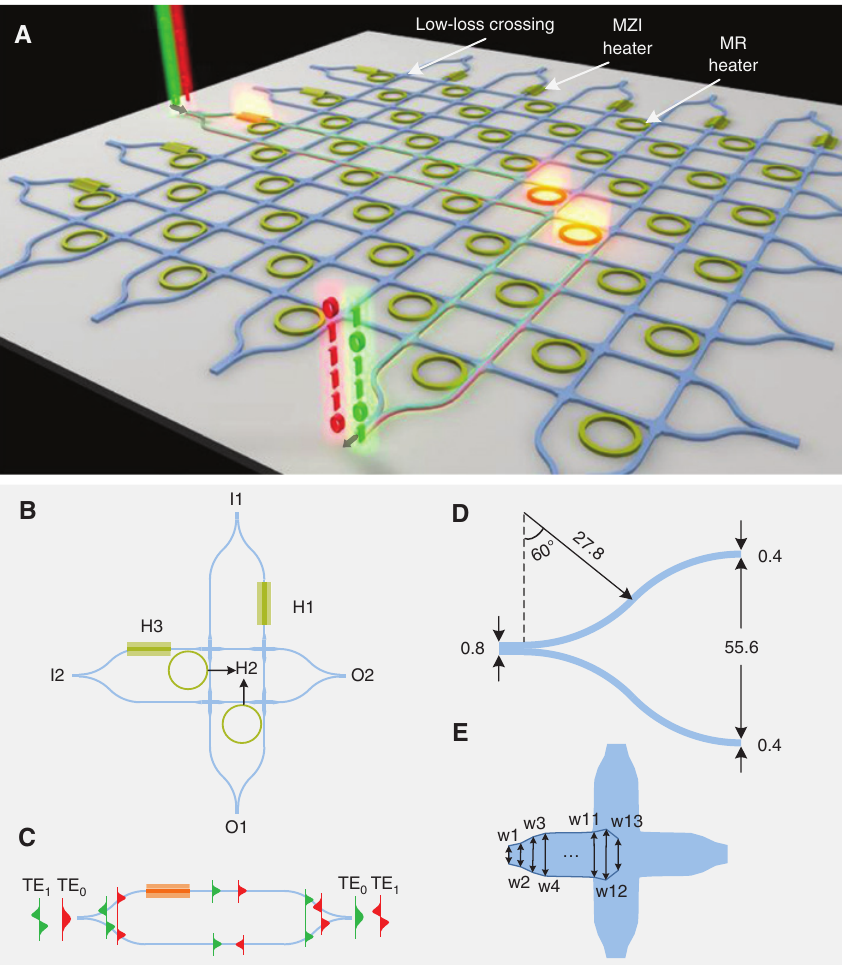
Figure 1: The proposed integrated multimode switch. (A) Schematic of high-port-count multimode switch fabric. The numeric strings with red and green colors stand for the signals carried on different modes. The signal can be selectively guided to the desired output port as the desired mode. (B) A 2 × 2 multimode switch element consisting of two Mach-Zehnder interferometer (MZI) based 1 × 1 multimode switches orthogonally intersecting with each other and two micro-ring (MR) based 2 × 2 single-mode switches. The thermal heaters are used for reconfigurable control. (C) MZI-based 1 × 1 multimode switch. The TE exchange with each other in the ON state. Schematic views of (D) the symmetric Y-junction and (E) waveguide